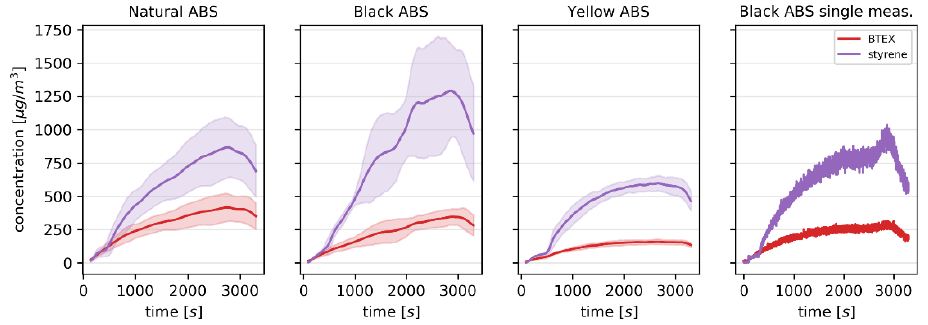
Figure 2. The concentration of styrene (purple) and the sum of m / z values characteristic for benzene, toluene, ethylbenzene and xylenes (red) in the 3D printer enclosure during printing with 3 different ABS filaments determined using proton transfer reaction mass spectrometry (PTR-MS). The solid line indicates the average ± standard deviation (shaded area). The final subplot illustrates data obtained during a single measurement.